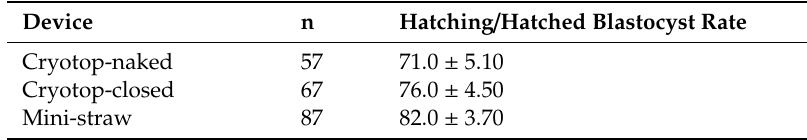
n: Number of embryos. Data are presented as least squares means ± standard error of the least squares